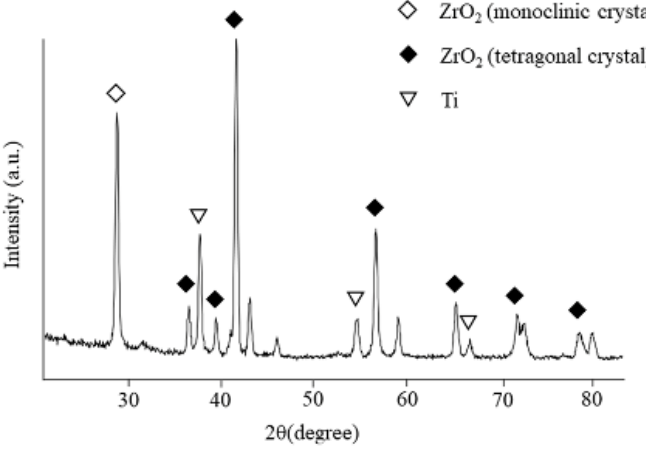
Figure 8. XRD patterns of the films on ZrO 2 /Ti disks.